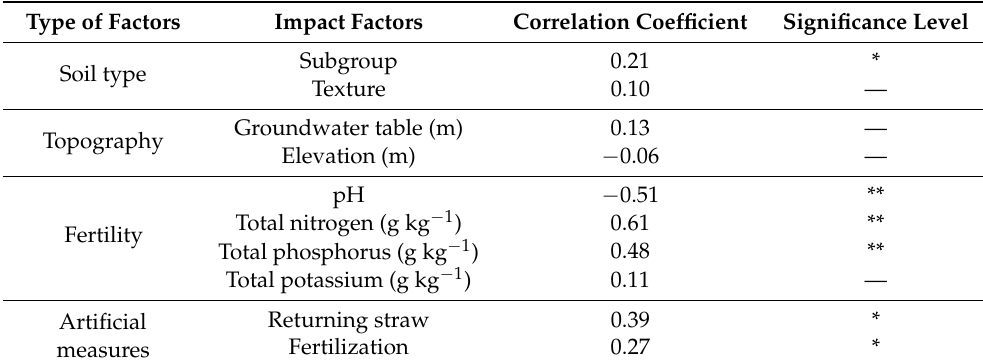
Table 3. Correlation analysis between the SOCD rate and related